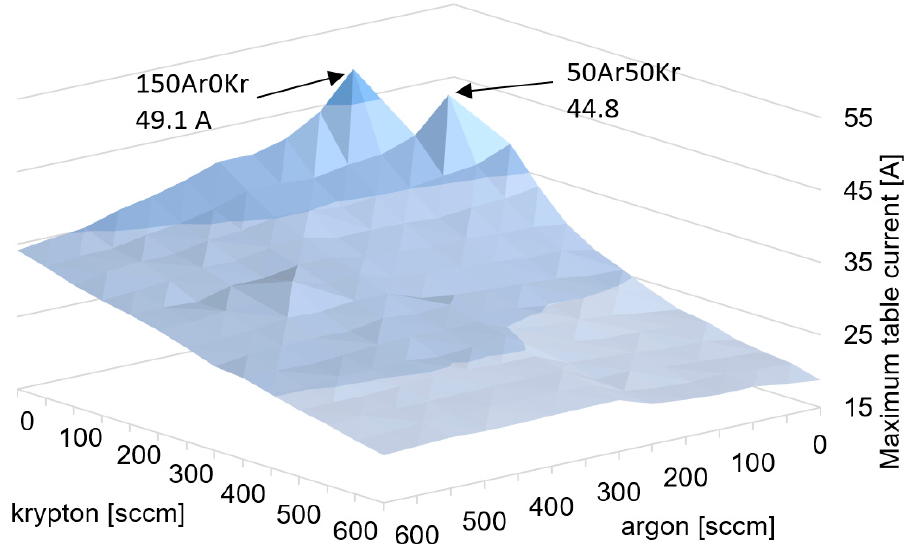
Figure 1. Results of the gas flow experiments with yttria-stabilized zirconia (3YSZ)-TiC.